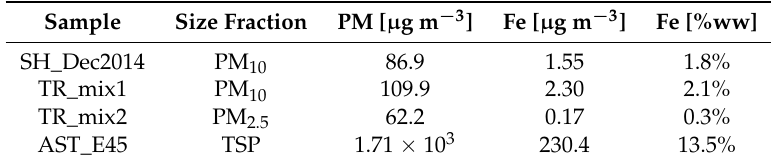
Table 1. Summary of samples analyzed in this work: total aerosol mass concentration and Iron